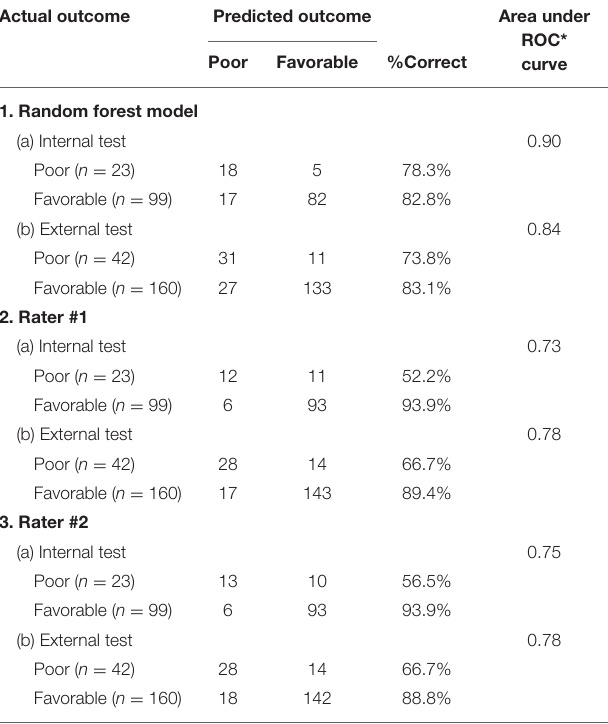
TABLE 3 | Comparison of performance between random forest model and two